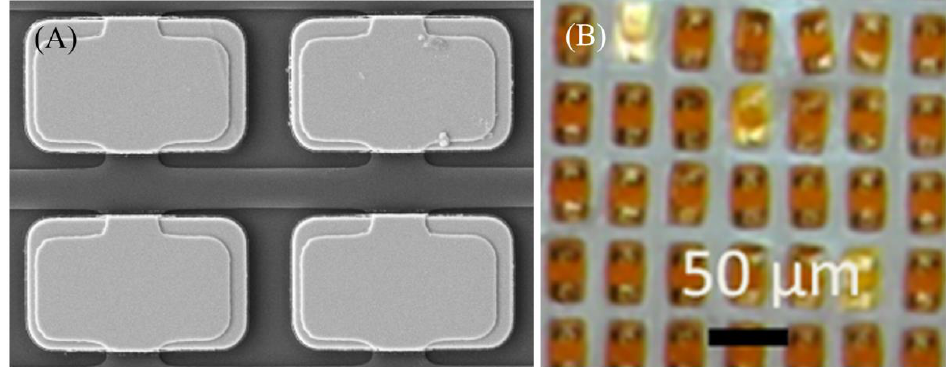
Figure 1. Image of μLED . ( A ) Scanning electron microscope (SEM) image of μLED. ( B ) The surface of the μLED array obtained by optical microscope. the µ LED array obtained by optical